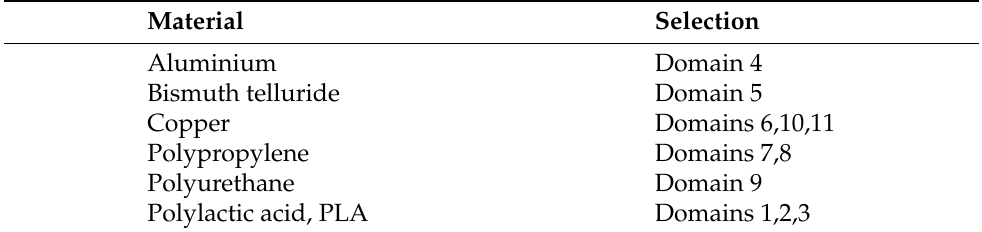
Table 4. Materials applied from the Comsol material library to the various domains.